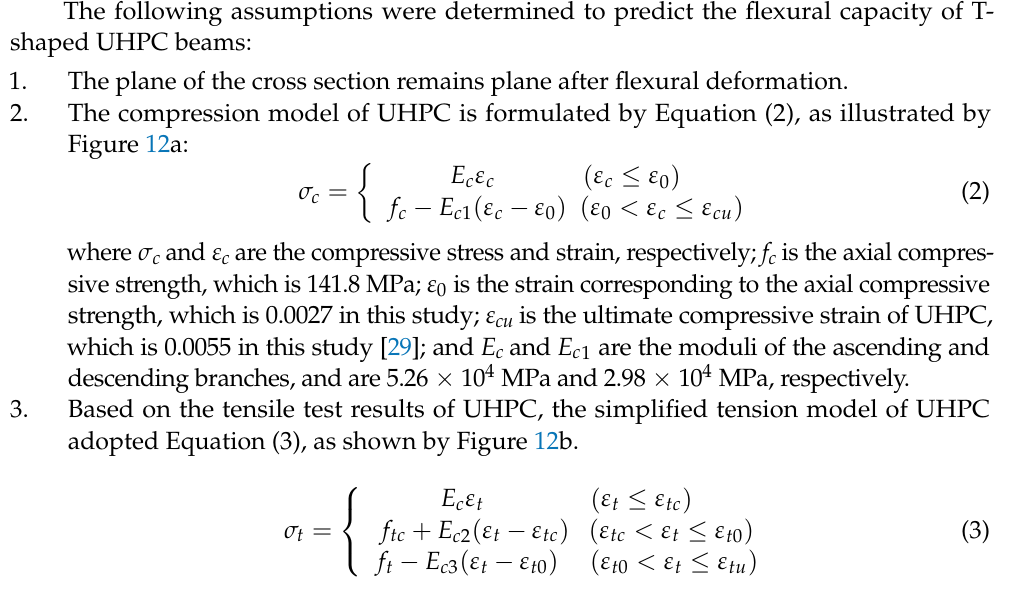
Figure 11. ρ l vs. peak loads of all beams.